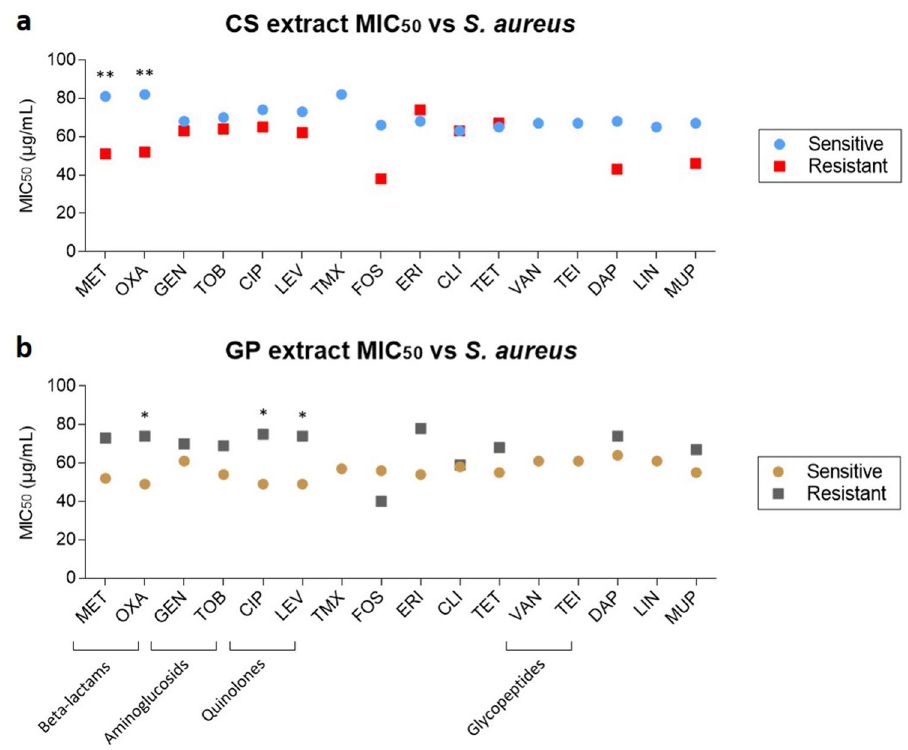
Figure 4. Comparative MIC 50 values of the CS extract ( a ) and GP ( b ) extracts against S. aureus isolates grouped by antibiotic sensitivity (circles) or resistance (squares). MET methicillin, OXA oxacillin, GEN gentamicin, TOB tobramycin, CIP ciprofloxacin, LEV levofloxacin, TMX trimethoprim/sulfamethoxazole, FOS fosfomycin, ERY erythromycin, CLI clindamycin, TET tetracycline, VAN vancomycin, TEI teicoplanin, DAP daptomycin, LIN linezolid, MUP mupirocin. Error bars are not included in this figure to minimize the symbols included on it but are included in Supplementary Fig. S4